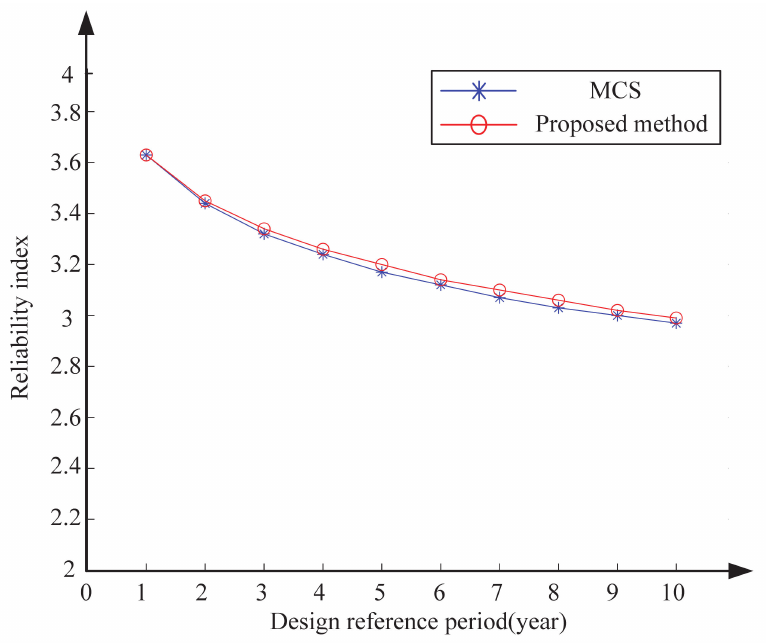
Figure 10. Reliability index curve of machine wing surface structure in design reference